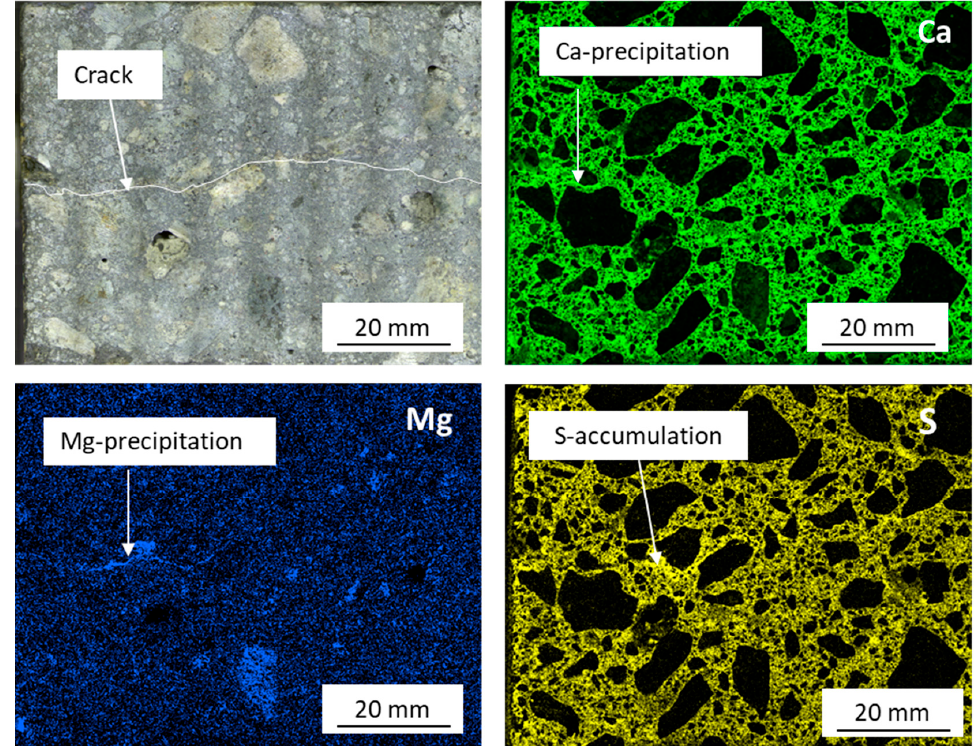
Figure 5. Overview picture (self-healed crack marked as white line) and µ-XRF elemental map of Ca (green), Mg (blue) and S (yellow) of PC-4SF20FA.